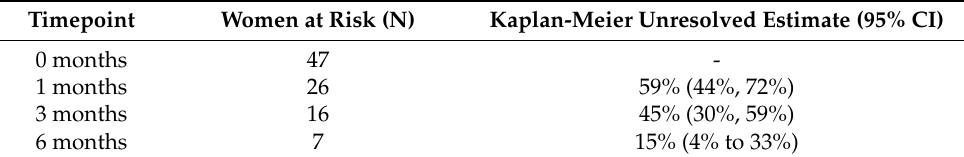
Figure 5. Kaplan-Meier plot of time to resolution for all women ( n =47). Table 2. Summary of unresolved rates over time.